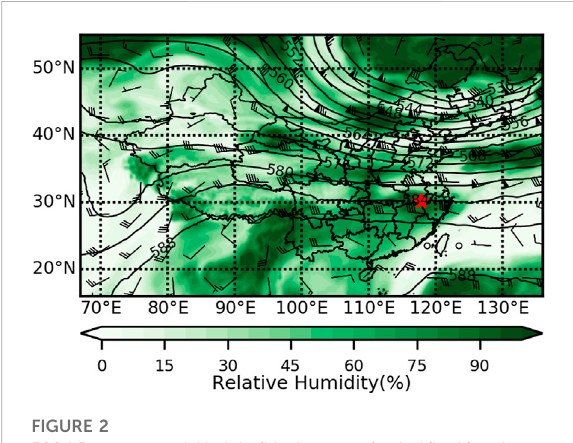
FIGURE 2 500 hPa geopotential height (black contour), wind (barb) and relative humidity (green shading) fi elds on 1 November 2020. Red star is the fl ight